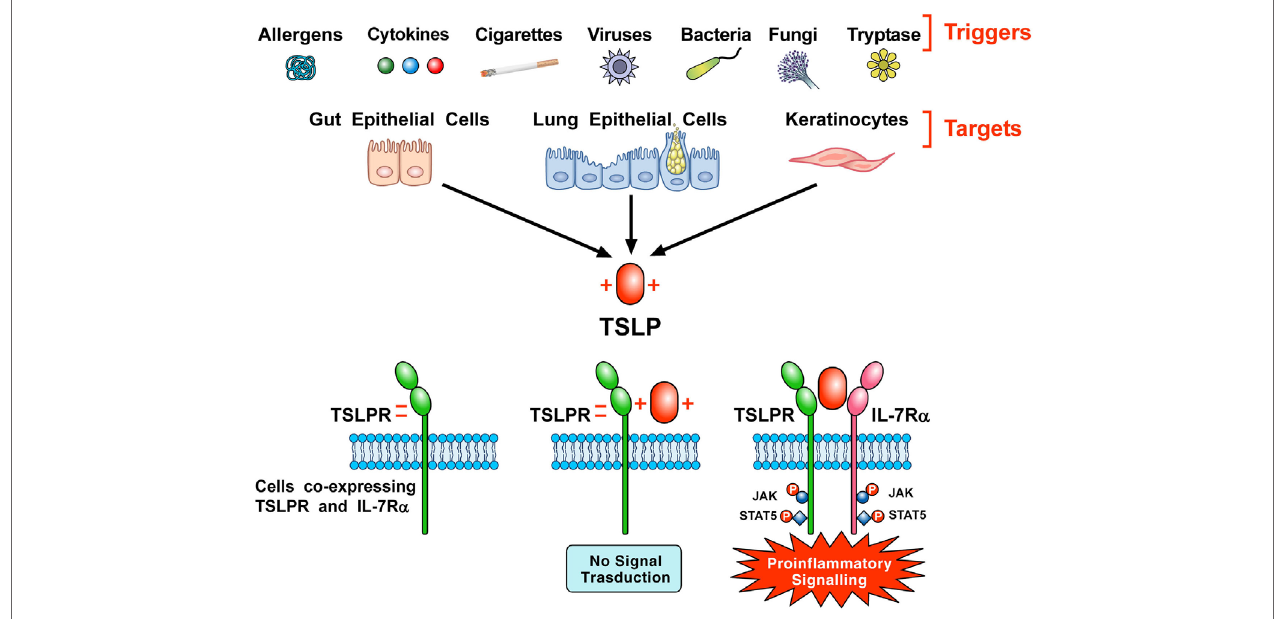
FiGURe 1 | Schematic representation of the production of thymic stromal lymphopoietin (TSLP) and its signaling complex via a cooperative stepwise mechanism on the surface of cellular targets. A plethora of triggers including allergens, cigarette smoke extracts, cytokines, viral, bacterial and fungal products, and tryptase can activate lung and gut epithelial cells and keratinocytes to release TSLP. The latter, which is positively charged, binds to thymic stromal lymphopoietin receptor (TSLPR), which is negatively charged, with high affinity and fast kinetics. Then, IL-7R α associates with performed TSLPR:TSLP binary complex to form the ternary TSLPR-TSLP-IL-7R α complex (44). This receptor complex on cells co-expressing TSLPR and IL-7R α phosphorylates JAK and STAT5 to initiate proinflammatory